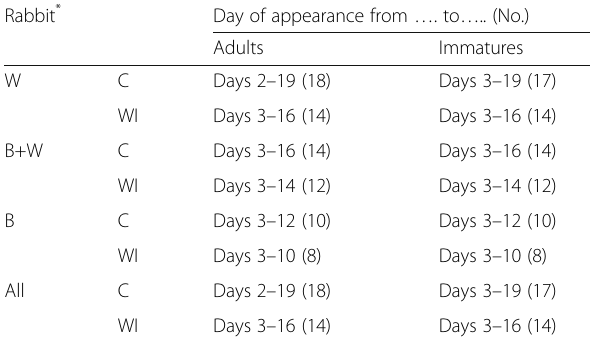
Table 1 Day ranges for the appearance of dipteran adults and immatures on control (C) and warfarin-intoxicated (WI) carcasses Rabbit * Day of appearance from … . to … .. (No.)